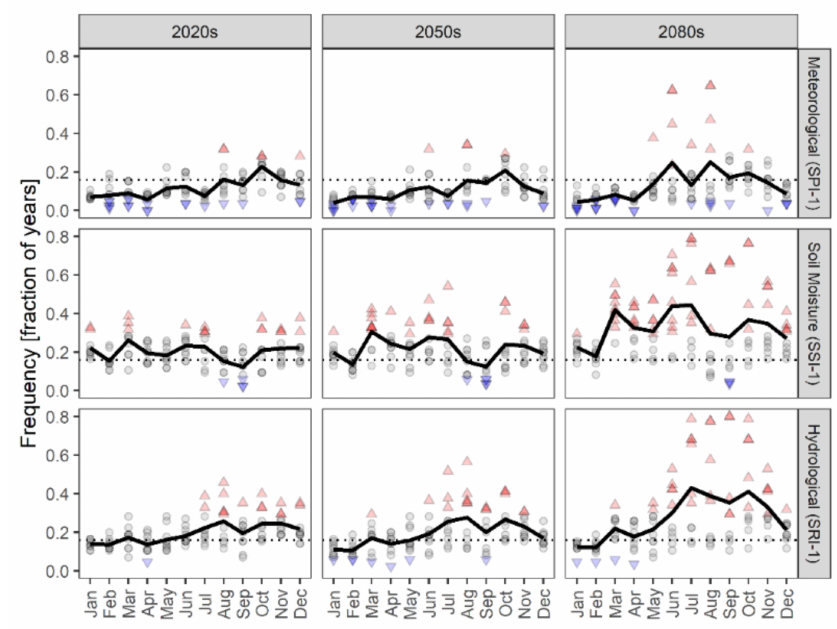
Figure 5. Projected change in the frequency of moderate to extreme meteorological, soil moisture, and hydrological droughts under representative concentration pathway (RCP) 8.5. Solid black lines show the GCM ensemble mean. Symbols represent individual GCMs from the 10-member ensemble, with red up-pointing triangles indicating a significant ( p < 0.05) increase in drought frequency and blue down-pointing triangles indicating a significant decrease in drought frequency from the historical baseline (1971–2000). Gray circles indicate no significant change. For the three future periods: 2020s = 2011–2040; 2050s = 2041–2070; and 2080s = 2070–2100. Figure S10 shows results for RCP